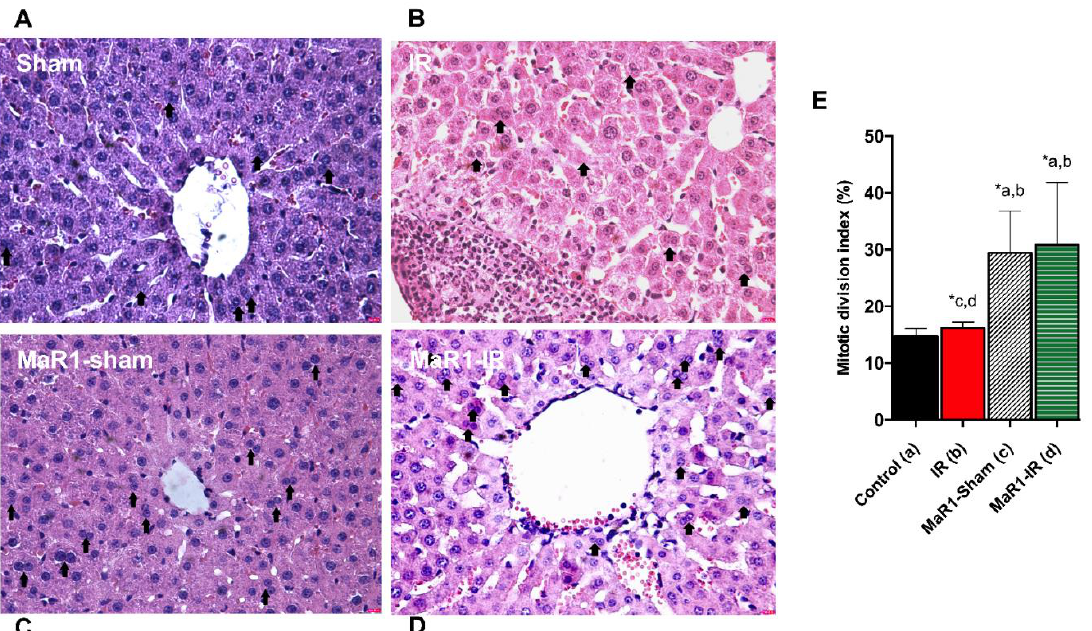
Figure 3. Impact of MaR1 on cell proliferation after IR. Representative microphotography of ( A ) Sham, ( B ) IR, ( C ) MaR1-sham, ( D ) MaR1-IR, and ( E ) mitotic activity index (MAI) measured as a percentage of a whole section, 20 fields for every sample were analyzed at 400 × magnification. n = 9 animals per experimental group. Asterisk indicates p < 0.05, and the letters identify the experiments that are compared and present this statistical difference.